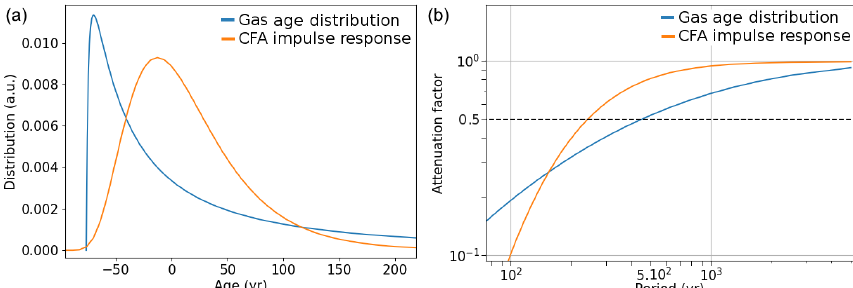
Figure 11. (a) Gas age distribution in the synthetic 1.5-million-year-old ice core in blue, and CFA impulse response on a gas age scale is shown in orange. (b) Attenuation of a sine signal by the firn and CFA smoothing in blue and orange respectively. The horizontal dashed line indicates the 50%